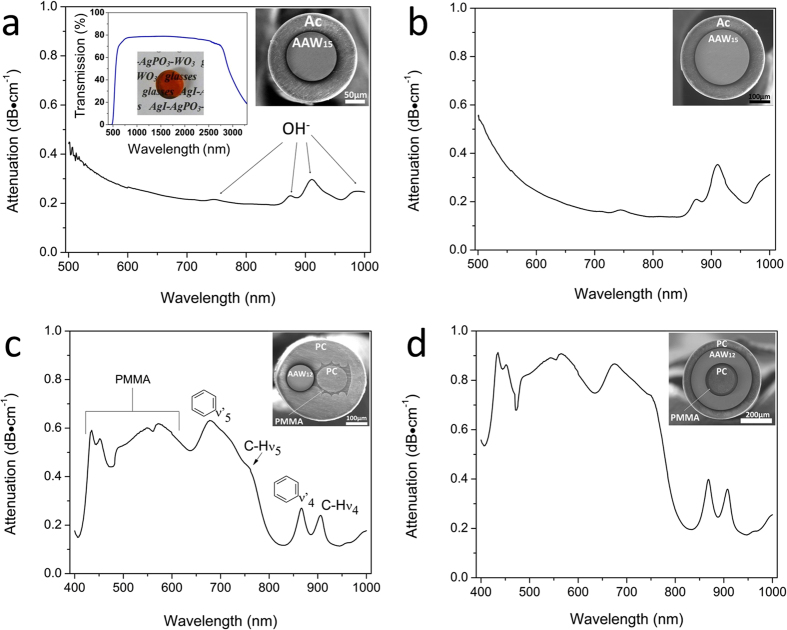
Attenuation spectra of: (a,b) the 125 μm and 250 μm diameter single-core AAW15 glass fibers with acrylic coating (Ac); (c) the two circular-core fiber with 125 μm diameter AAW12 glass and 140 μm diameter PC cores and; (d) the ring-core fiber with a PC cladding ring of 45 μm thickness, an electrically conductive AAW12 glass ring of 90 μm thickness, a PMMA ring of 25 μm thickness, and a PC core of 155 μm diameter. Corresponding SEM cross-section images of the fibers are shown in inset. Glass labels: AAW12: 45AgI-43-AgPO3-12WO3, AAW15: 45AgI-40-AgPO3-15WO3.